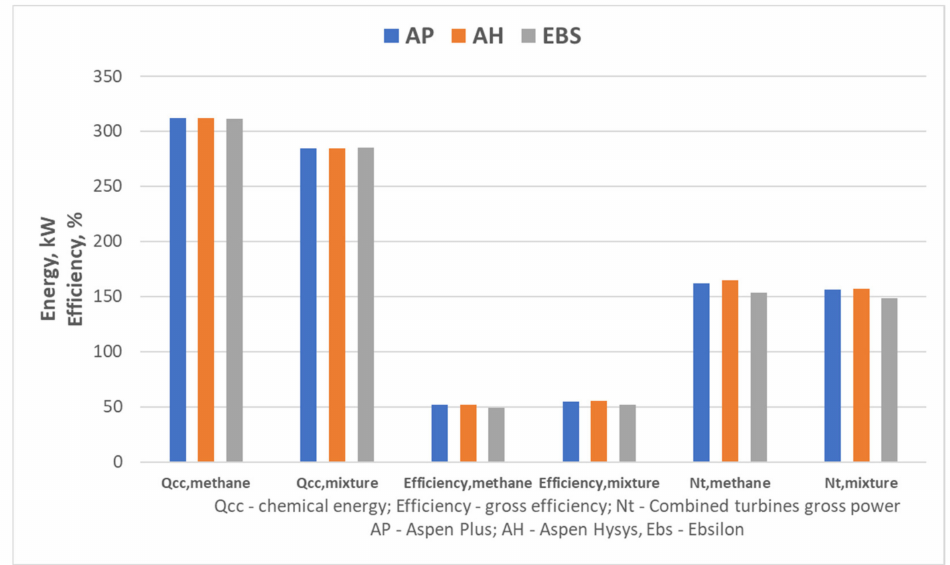
Figure 11. Combined turbine power, chemical energy of mixture 1 and methane combustion, and gross efficiency for various computing codes (AP—Aspen Plus, AH—Aspen Hysys,